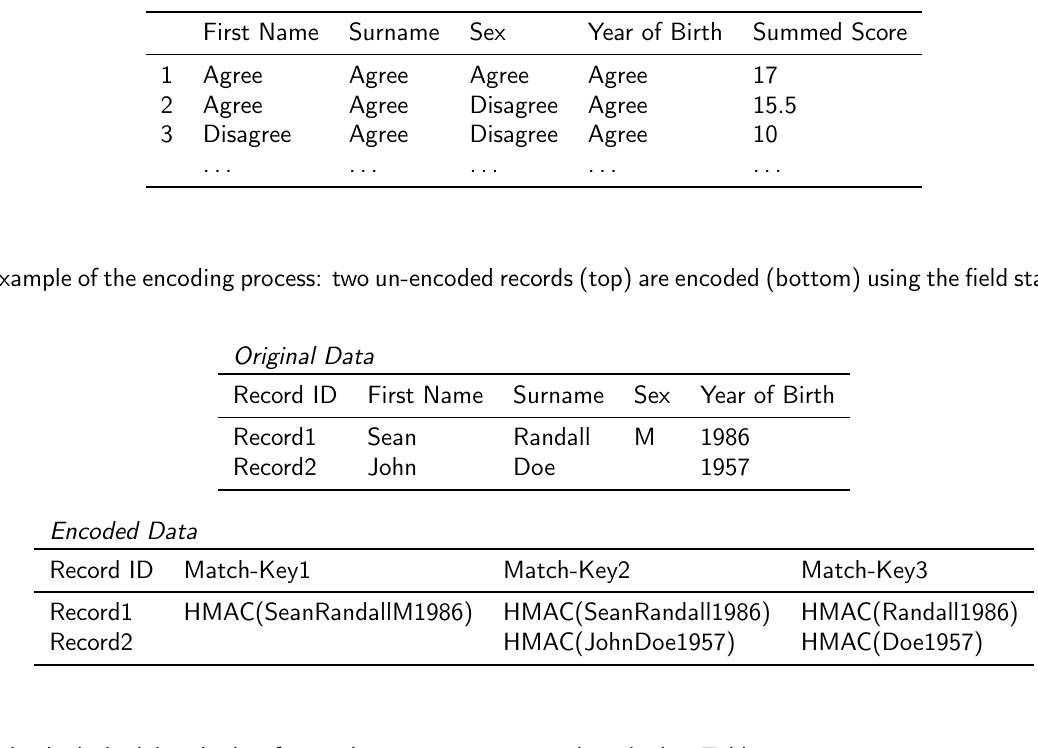
Table 1: A list of field state combinations (16 different states are possible as there are four fields)